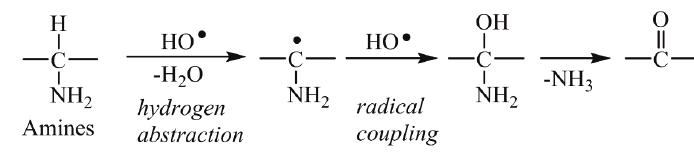
/ 1a ( Δ ) against 1a /catalyst in TiO 2